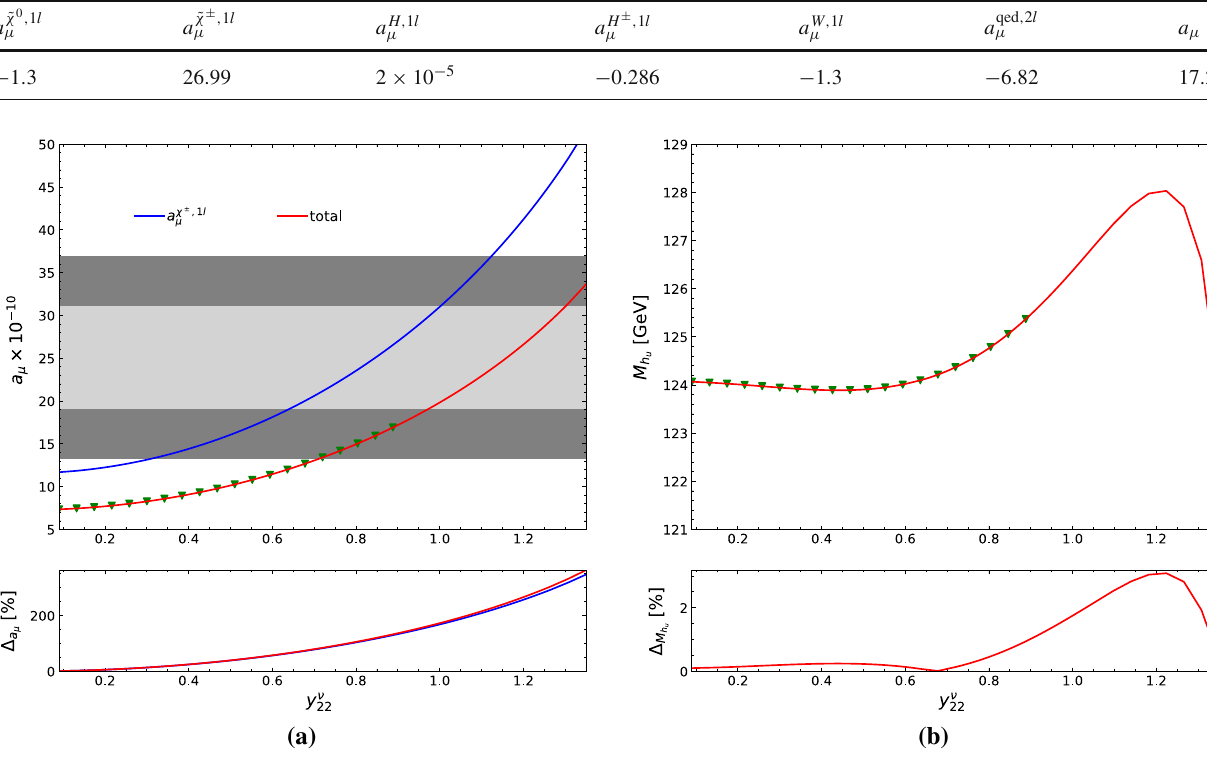
Fig. 2 Upper left: The one-loop chargino contribution (blue) and the sum of all contributions (red) to the AMM of the muon in the NMSSM- nuSS. Lower left: The corresponding relative difference defined as (cid:7) (cid:7) ( a x (cid:3) = ( NMSSM-nuSS ) − a x ( NMSSM ))/ a x μ μ a μ in the M X parameterization. Upper right: The as a function of y ν 22